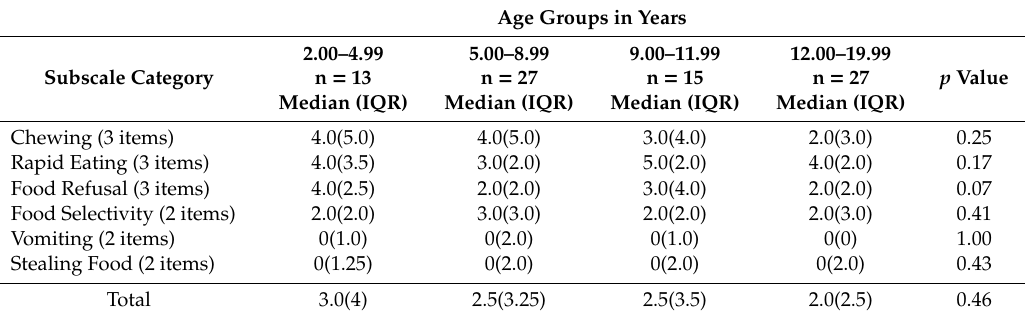
Table 6. Medians and interquartile ranges (IQR) of total STEP-Child and age subscale